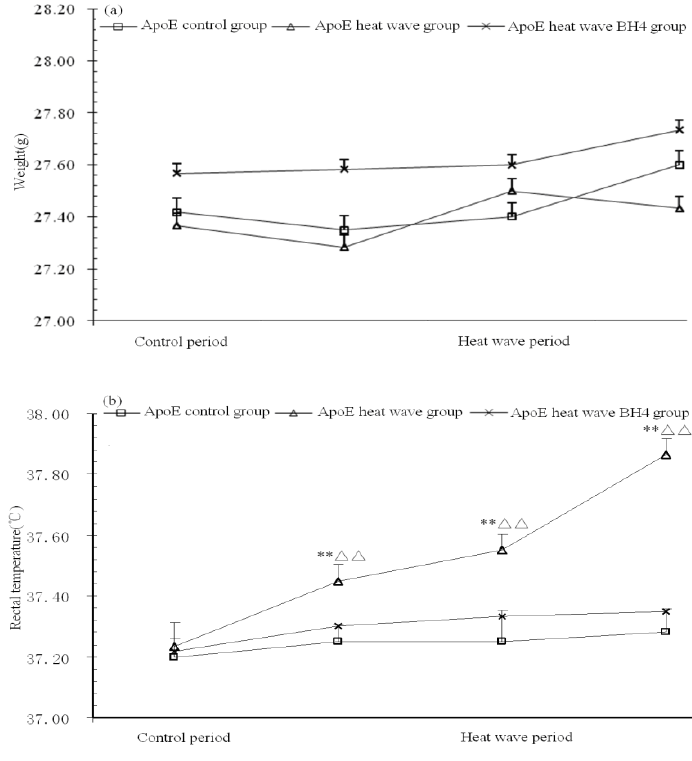
Figure 2. Body weight ( a ) and rectal temperature ( b ) of ApoE-/- mice. ** p < 0.01 vs. control group; △△ p < 0.01 vs. heat wave BH4 group at time of